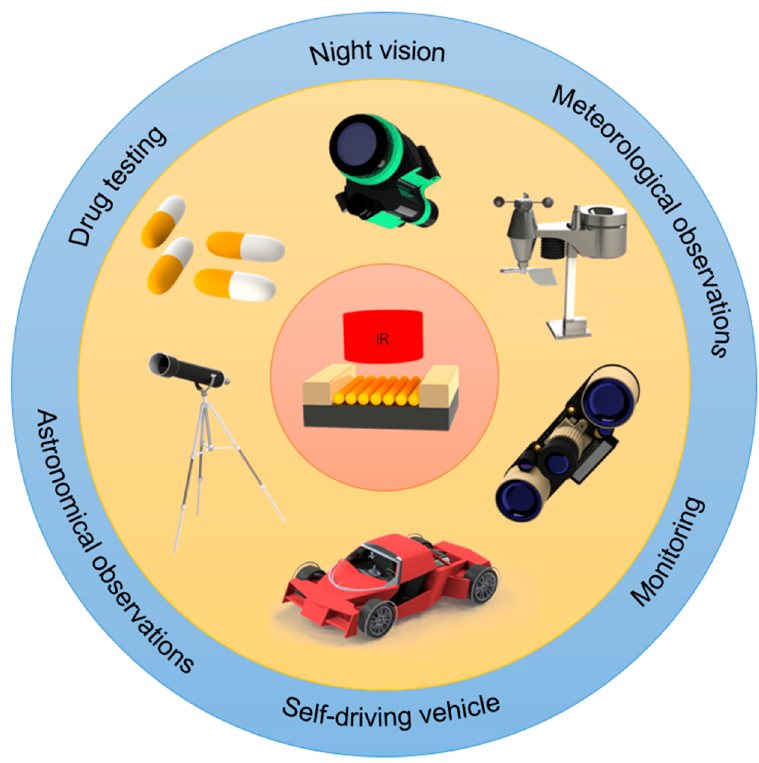
Figure 1. Potential applications of infrared PDs.